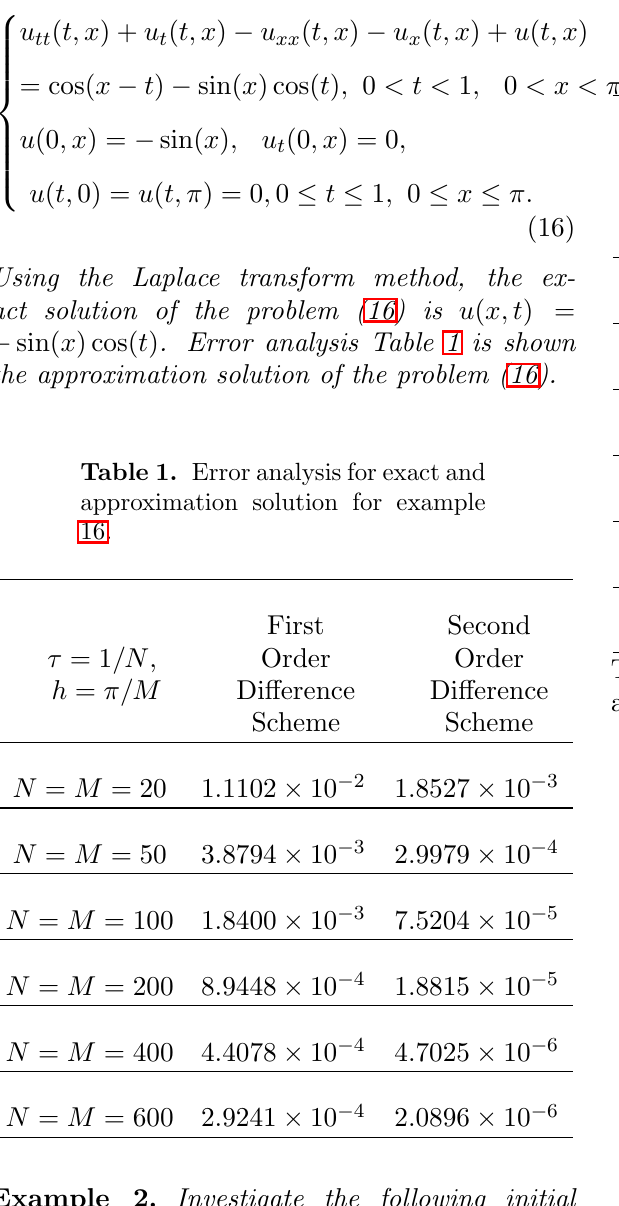
Figure 1. Figure of exact solution for problem16, where N=M=20.